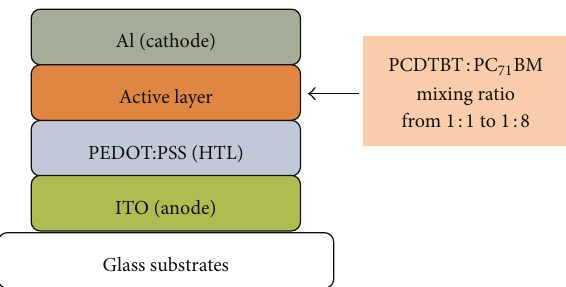
Figure 2: Schematic diagram of the